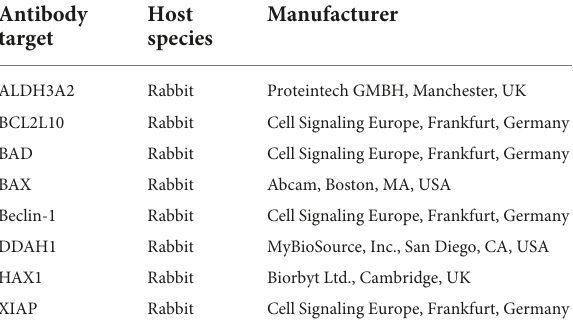
TABLE 1 List of antibodies used for the microarray analysis. Antibody